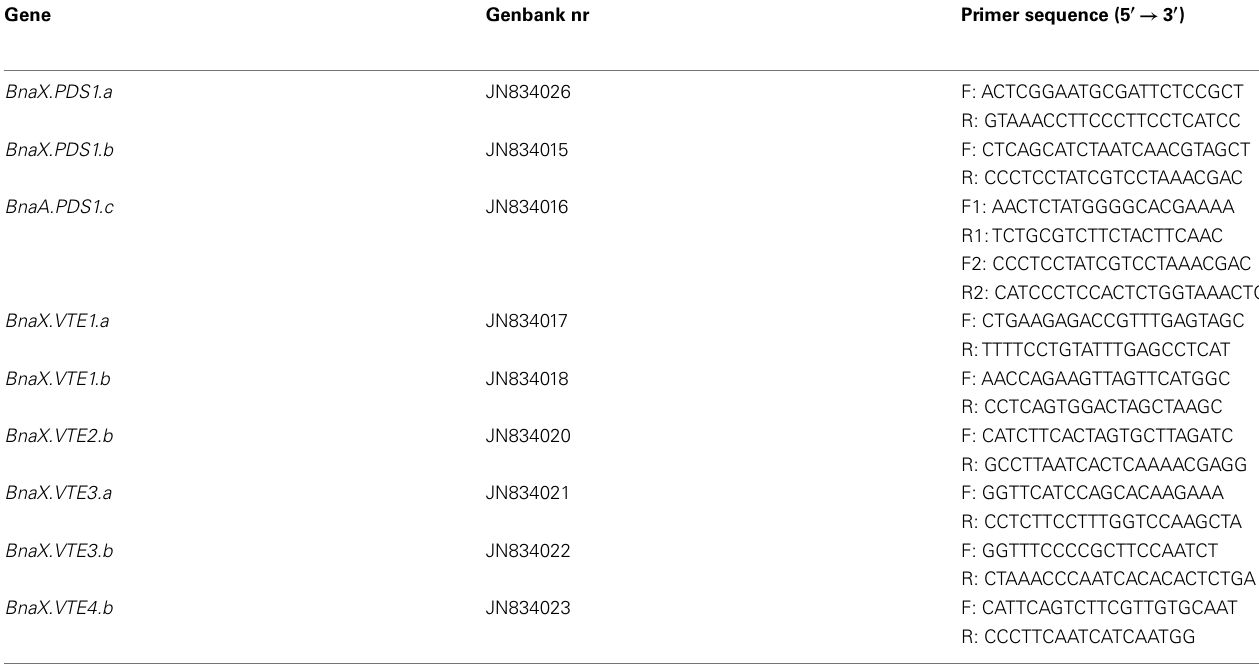
TableA2 | Primer used for the amplification of tocopherol genes.